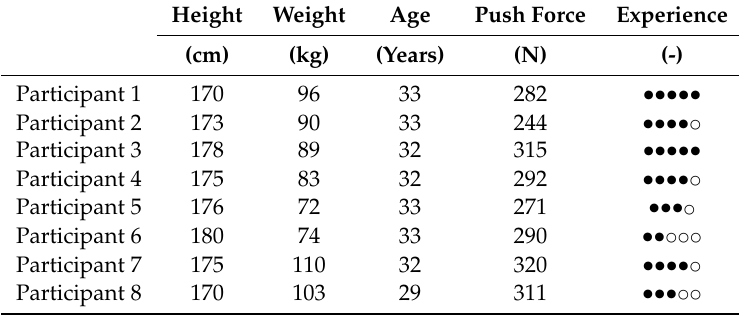
● qualitative assessment of the driving skills of the wheelchair, where the ○ representing the user’s